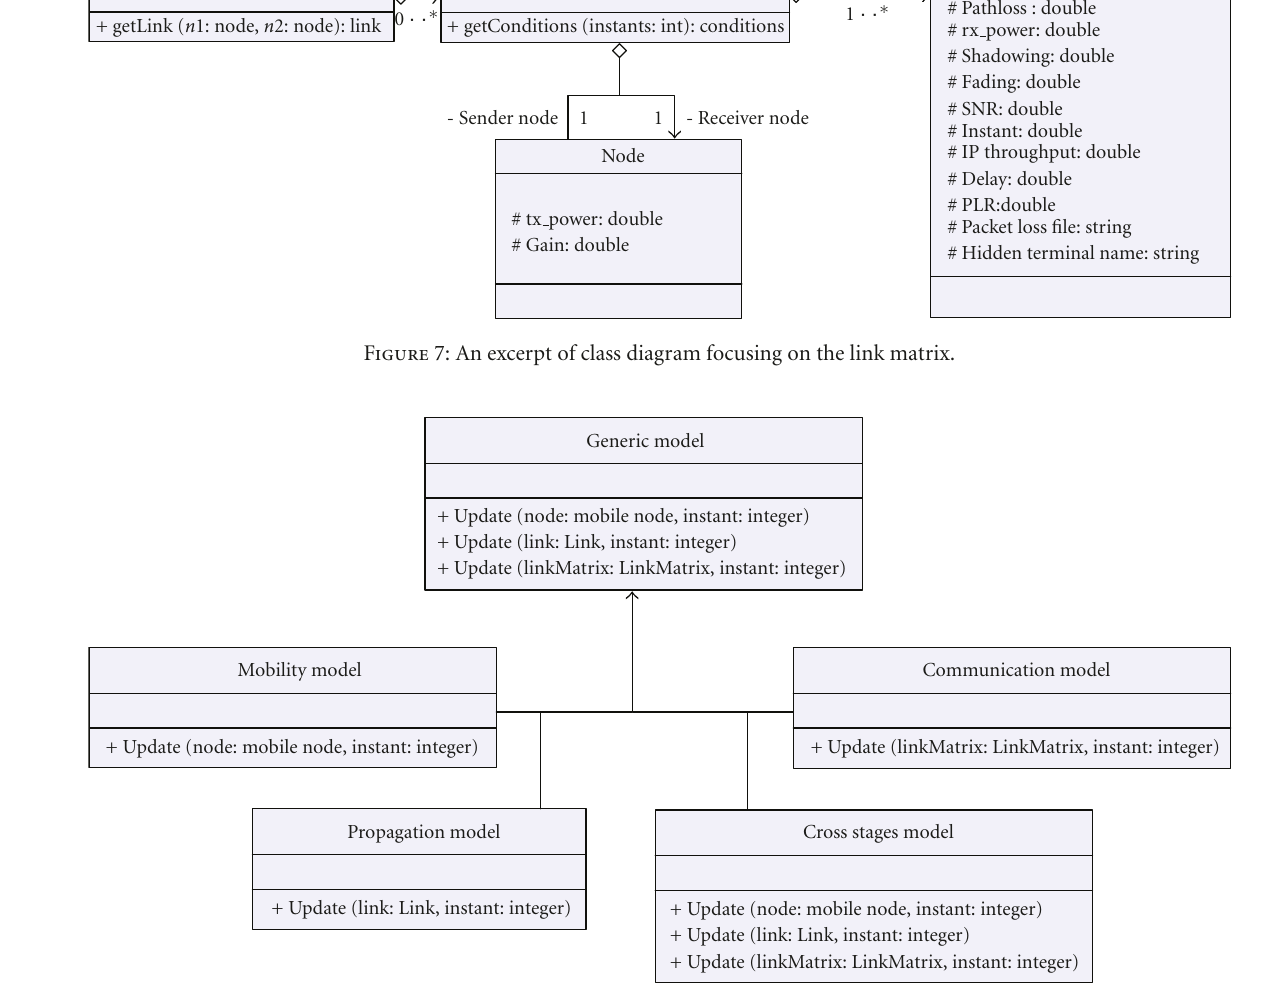
Figure 8: An excerpt of the class diagram focusing on